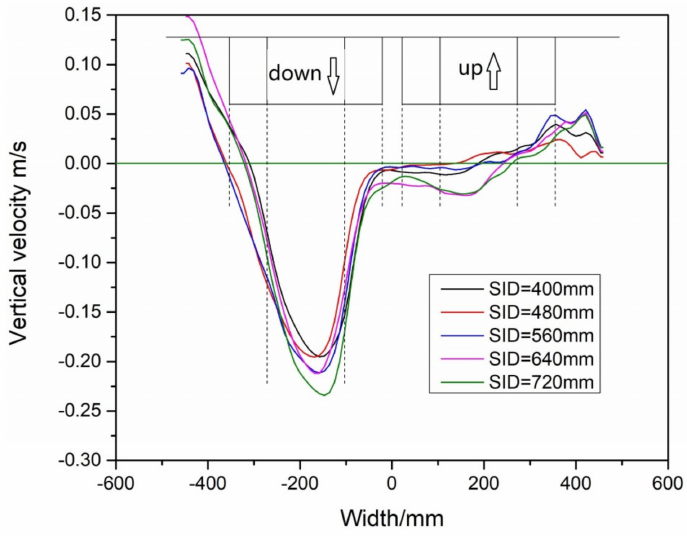
Figure 10. Vertical velocity distribution of flow field in mixing layer with di ff erent